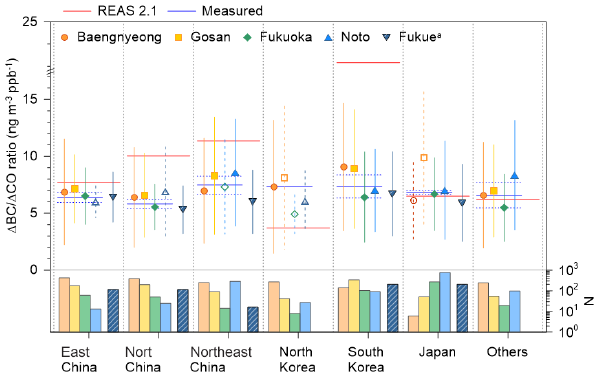
Figure 3. (cid:49) BC /(cid:49) CO ratios at the four measurement sites and Fukue from Kanaya et al. (2016) according to the dominant emis- sion region. The symbols with vertical lines are the means and stan- dard deviations of the (cid:49) BC /(cid:49) CO ratio. The bar graph on the bot- tom indicates the number of data in the dominant emission region. Open symbols with dashed vertical lines indicate data excluded be- cause of a low number of data. The solid blue horizontal lines with dashed lines for each region indicate the means and standard devia- tions of the measured (cid:49) BC /(cid:49) CO, excluding the areas with limited data. The solid red horizontal lines depict the overall mean BC / CO ratios of dominant emission regions from the REAS version 2.1 emission inventory (Kurokawa et al.,